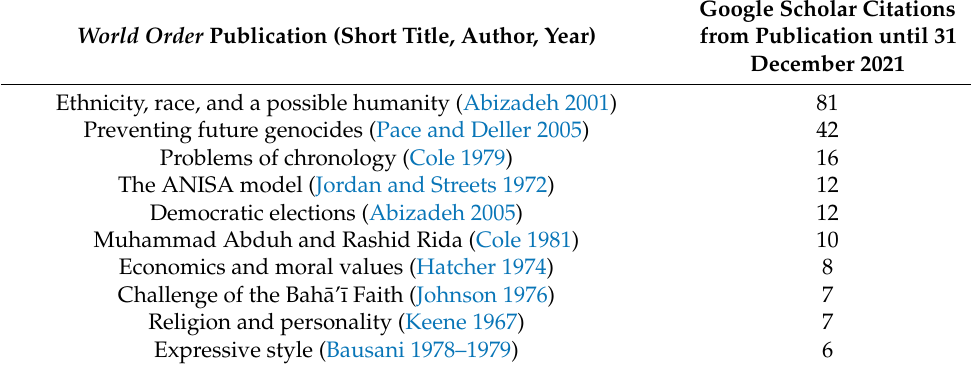
Table 3. Total number of citations to World Order